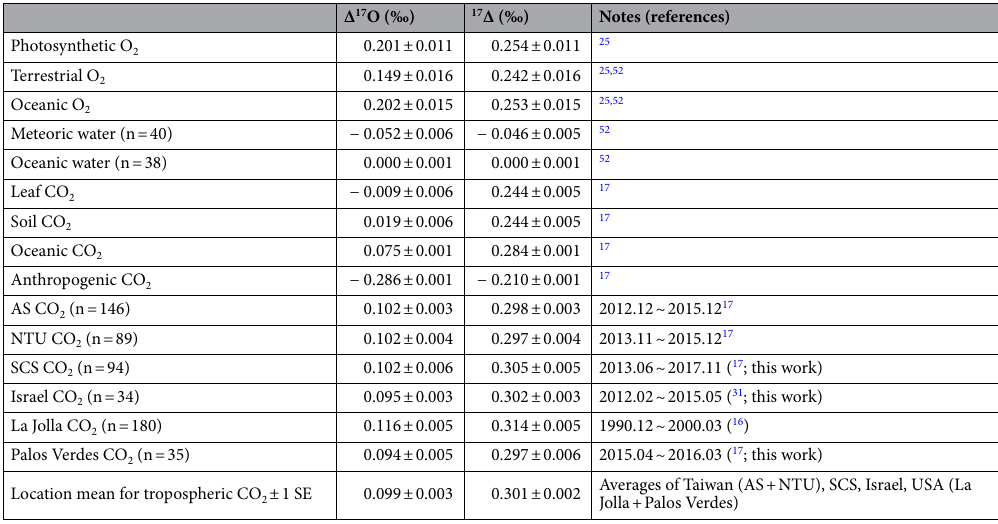
Table 1. Δ 17 O values used in the work for the oxygen isotope recycling time and GPP derivations. 17 Δ in logarithmic scale is defined as 17 Δ = ln(1 + δ 17 O) – 0.516 × ln(1 + δ 18 O). O 2 values are reported